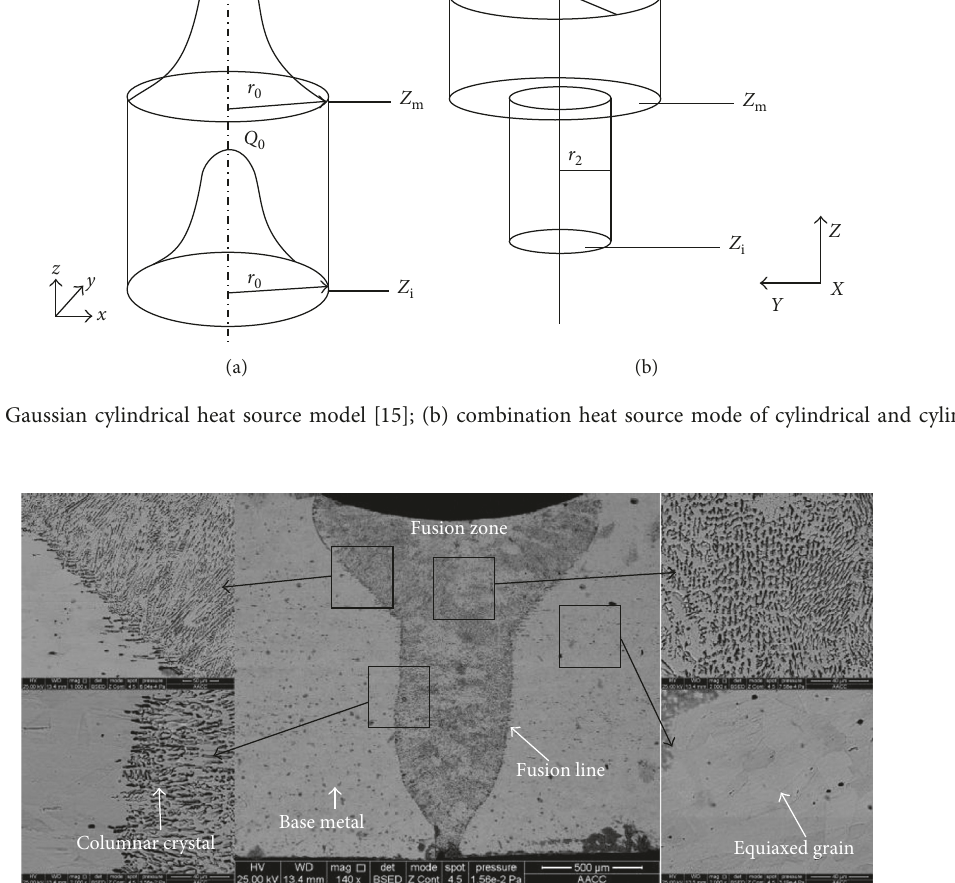
Figure 4: SEM micrographs of the trial welding